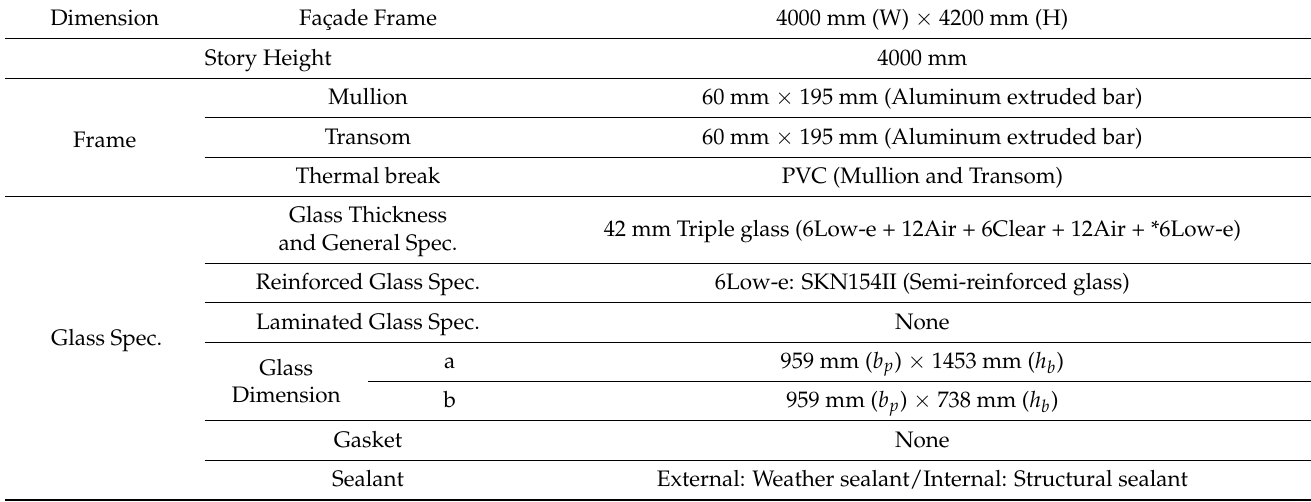
Figure 10. Non-seismic curtain wall specimen: ( a ) front view; ( b ) side view. Table 4. Designed member specifications of non-seismic specimen